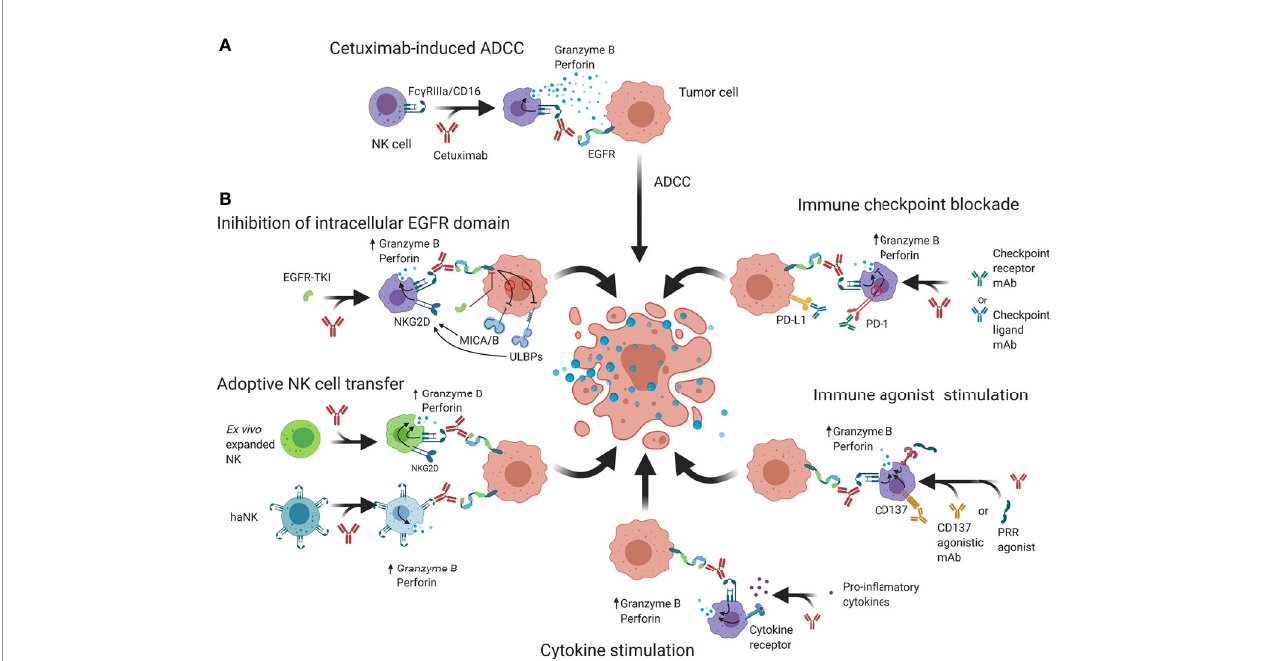
FIGURE 3 | Schematic overview of possible strategies that may be employed to enhance cetuximab-based anticancer NK cell responses. (A) Cetuximab is a mAb that interacts with Fc g RIIIa/CD16 receptors on NK cells and EGFR on tumor cells to abrogate EGFR signaling and induce granzyme B and perforin release, causing cell death. (B) NK cell cytotoxicity may be enhanced by additional binding of intracellular EGFR kinase domains that can regulate expression of NK cell receptors. Genetically engineered NK cells such as haNK or CAR-NK have increased natural cytotoxicity and activating signaling which through adoptive transfer can enhance ADCC. Immune checkpoint blockers prevent suppression of NK cell functions by reducing inhibitory signaling while immune agonists aim to increase activating signals. Cytokine stimulation increases NK cell functions and allows an enhanced ADCC response to take place. ADCC; Antibody-dependent cell-mediated cytotoxicity; CAR, Chimeric antigen receptor; EGFR, Epidermal growth factor receptor; IL-2/12/15/21; Interleukin 2/12/15/21; MICA/B, MHC class I polypeptide – related sequence A/B; NKG2D, Natural killer group 2D; PD-1, Programmed cell death protein 1; PD-L1, Programmed death-ligand 1; PRR; Pathogen recognition receptors; ScFv, Single-chain variable fragment TKI; Tyrosine kinase inhibitor; ULBP, UL16 binding